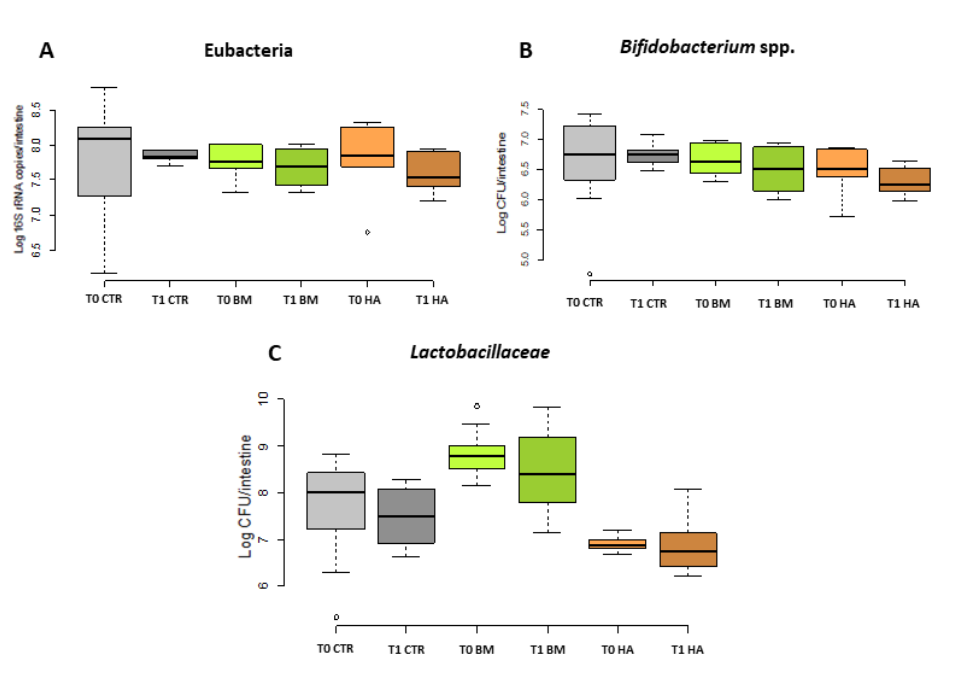
Figure 2. qPCR. quantification of ( A ) total bacteria (Eubacteria), ( B ) Bifidobacterium spp. and ( C ) Lac- tobacillaceae. Data are expressed in Log CFU/intestine for Bifidobacterium spp. and Lactobacillaceae; for Eubacteria data are expressed as Log 16S rRNA copies/intestine. [CTR] Control, [BM] Bacterial Mixture and [HA] HiveAlive TM .